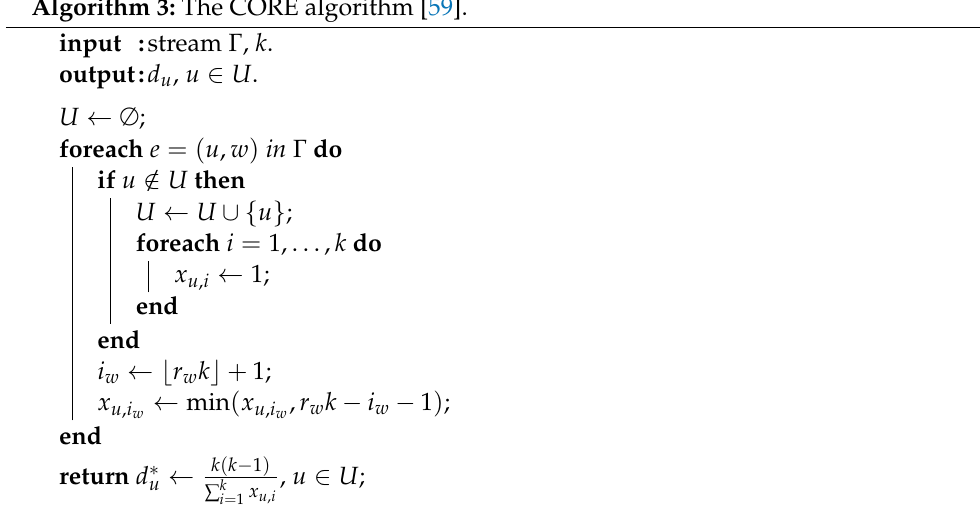
Algorithm 3: The CORE algorithm